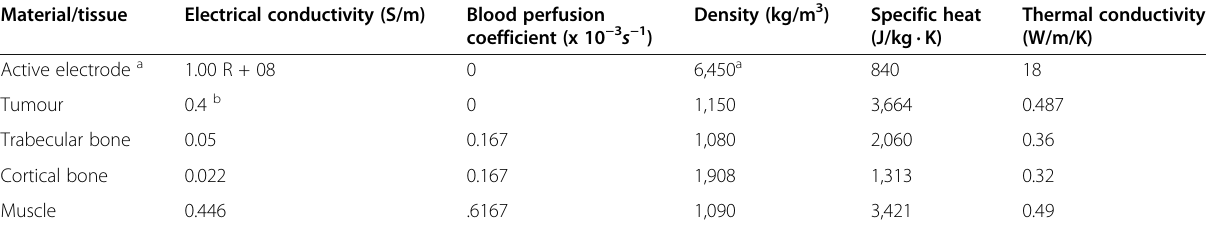
Table 1 Tissue and material properties Material/tissue